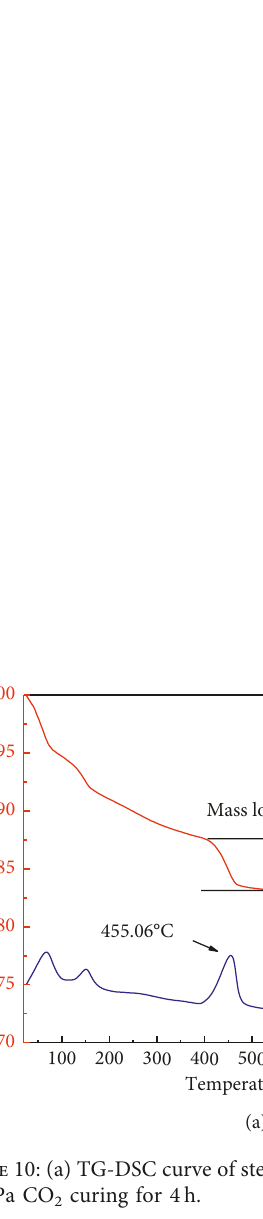
2 curing for 4h. (b) TG-DSC curves of microbial mineralized steel slag under